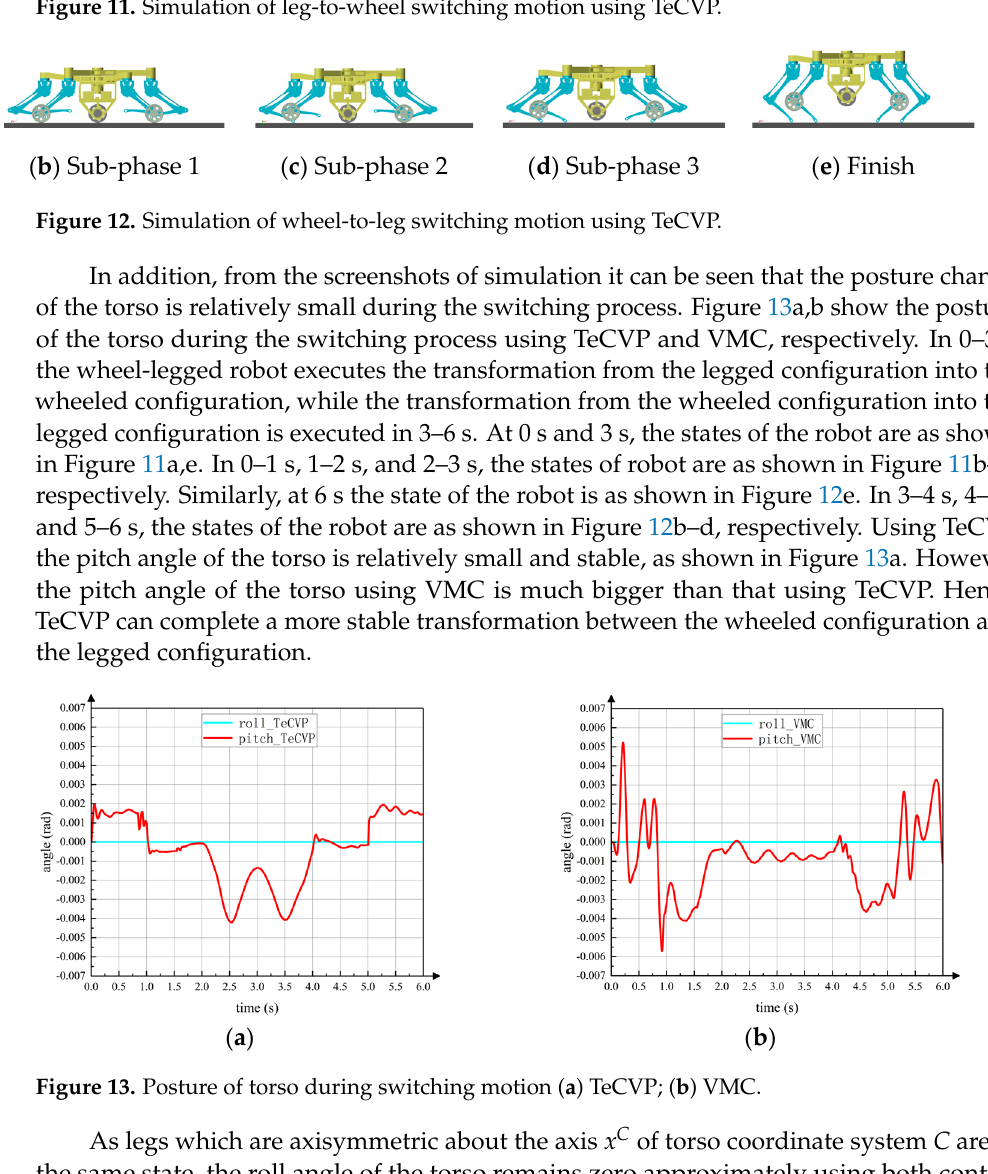
( d ) Figure 14. Simulation of wheeled motion (all wheels on slope). ( a ) no wheel on slope; ( b ) front wheels on slope; ( c ) front wheels and active wheel on slope; ( d ) all wheels on slope. The curve in Figure 15a is the vertical component of the contact force between the active wheel and ground. The horizontal axis is the simulation time. The front wheels, the active wheel and the rear wheels start moving on the slope at 1.4 s, 2.3 s and 2.8 s, respec- tively, which is same in the following simulations. It can be seen that contact force between the active wheel and the ground remains relatively stable during the entire wheeled mo- tion. The contact force feedforward and posture feedback adjustment strategies can en- sure that the active wheel touches ground when the robot passes over the gentle slope.